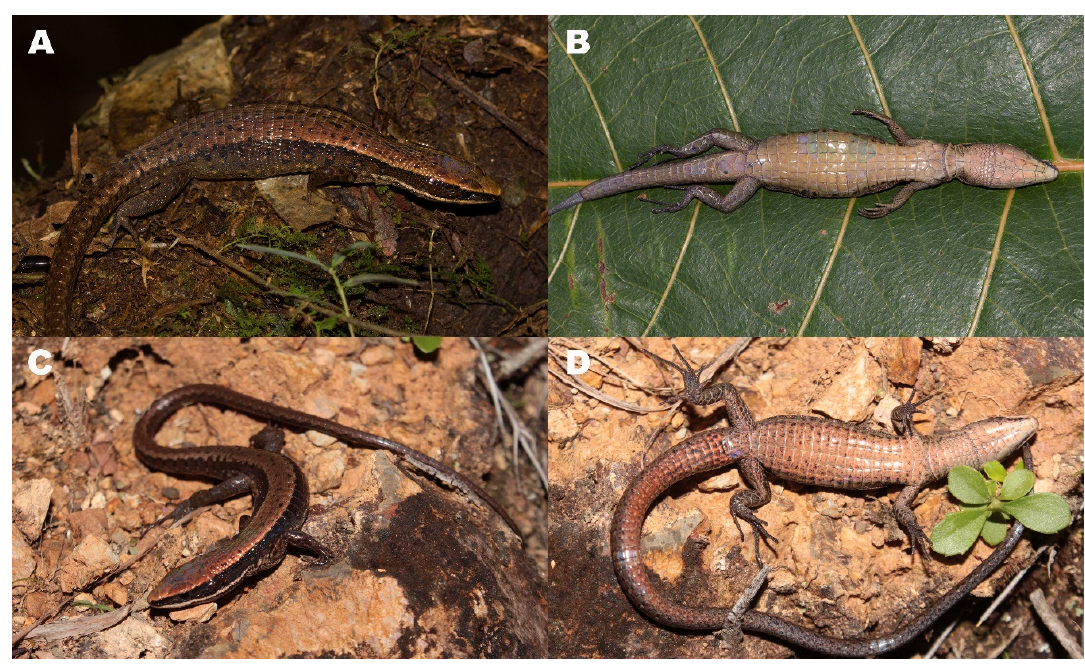
Figure 4. Live specimens of Cercosaura anomala . ( A , B ) Adult females (Urusayhua, Vilcabamba, ( A ) MUBI 13626, SVL = 68.2 mm, ( B ) MUBI 13328, SVL = 72.1 mm); ( C , D ) Adult male (Quellouno, La Convención, MUBI 16169, SVL = 56.2 mm). Photo: (A, B) Luis Mamani, (C, D) Juan C. Chavez-Arribasplata.